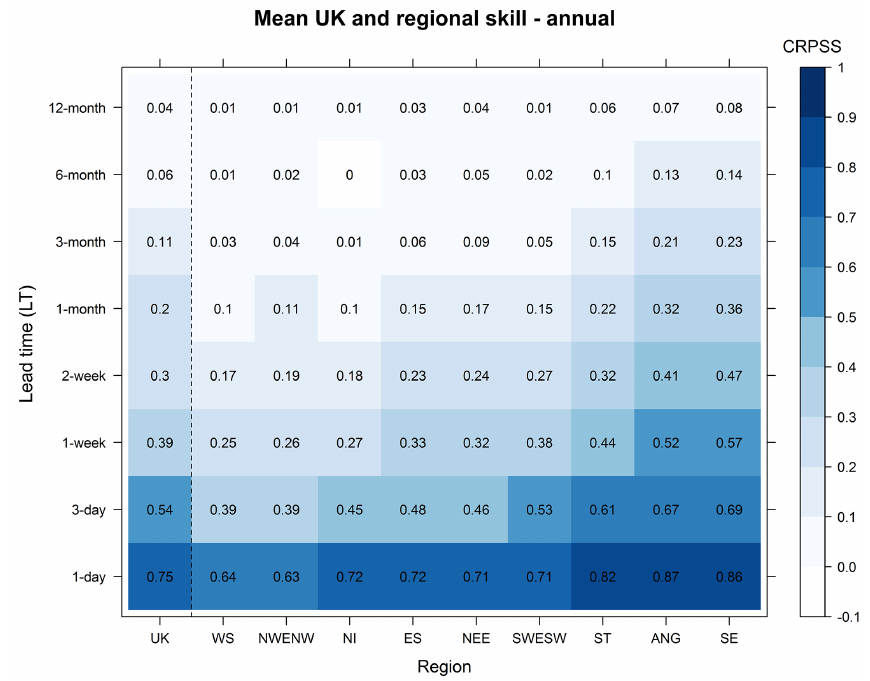
Figure 6. Mean ESP skill across all 12 forecast initialization months for the UK and for each of the nine hydroclimate regions ordered from least to most skilful (horizontal axis) at eight sample lead times (vertical axis). Skill is given by the CRPSS with darker and lighter shades showing higher and lower skill, respectively; mean skill score values are shown within each